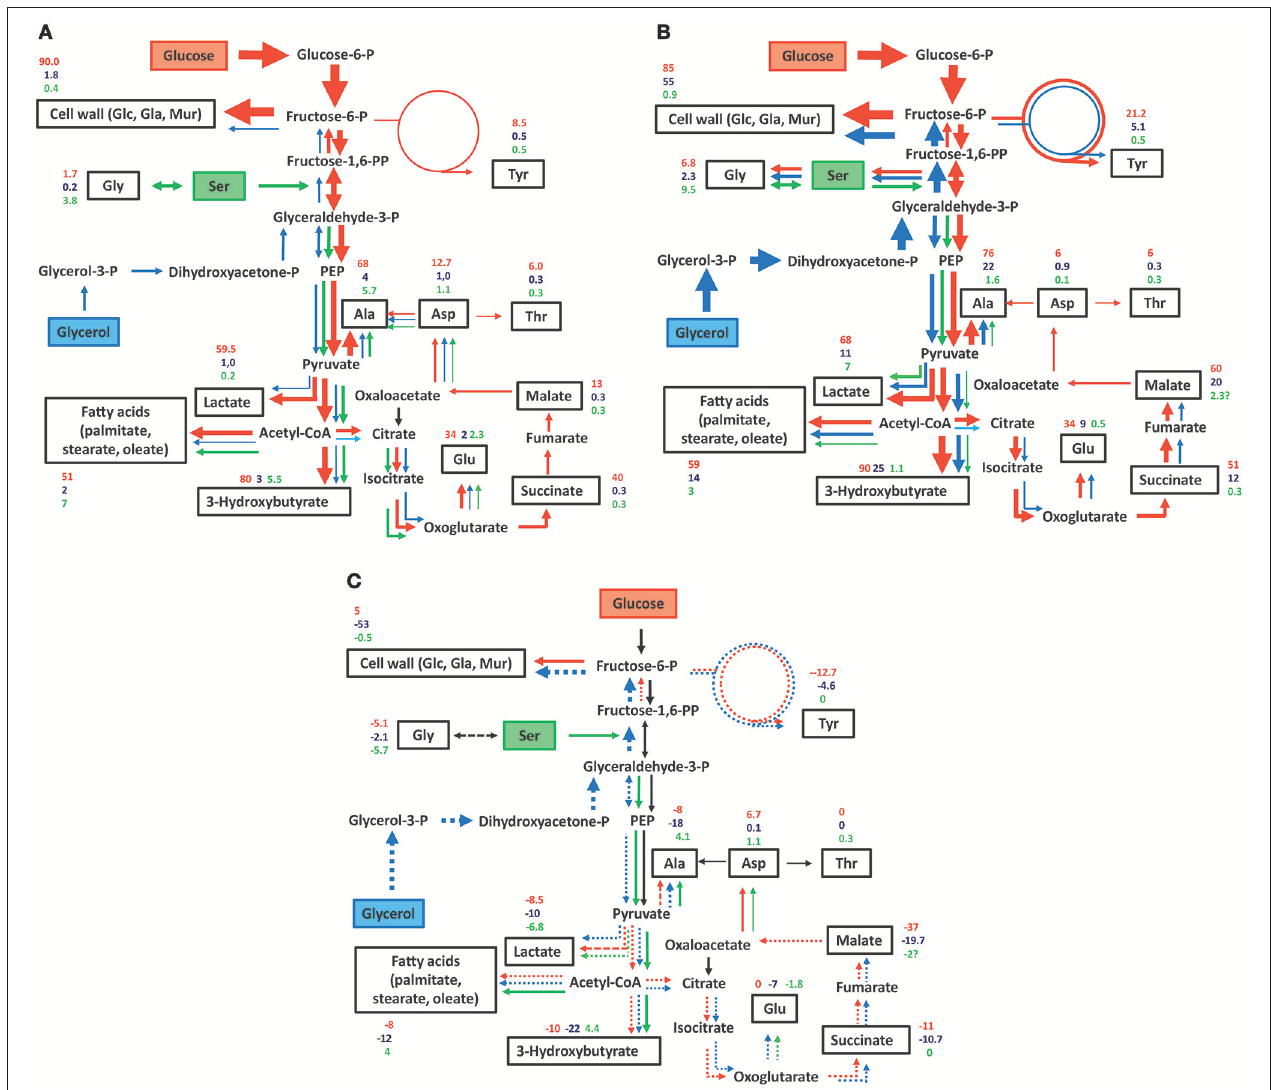
FIGURE 6 | Observed metabolic pathways and fluxes in (A) Fth Beaver/ Fth LVS, and (B) Fno from exogenous glucose (red arrows), serine (green arrows), and glycerol (blue arrows). (C) Differences in the metabolic fluxes between Fth and Fno ( Fth – Fno ). Metabolites studied by GC-MS-based isotopolog profiling are indicated by black boxes. The numbers indicate normalized overall 13 C-enrichments (from labeled glucose, glycerol and serine in red, blue and green, respectively). The arrow widths roughly indicate the relative fluxes. Fluxes conducive to enrichments < 1% are not shown. In (C) the numbers indicate the differences in the normalized overall 13 C-enrichments ( Fth – Fno ). Higher fluxes in Fth are indicated by normal arrows, lower fluxes by dashed